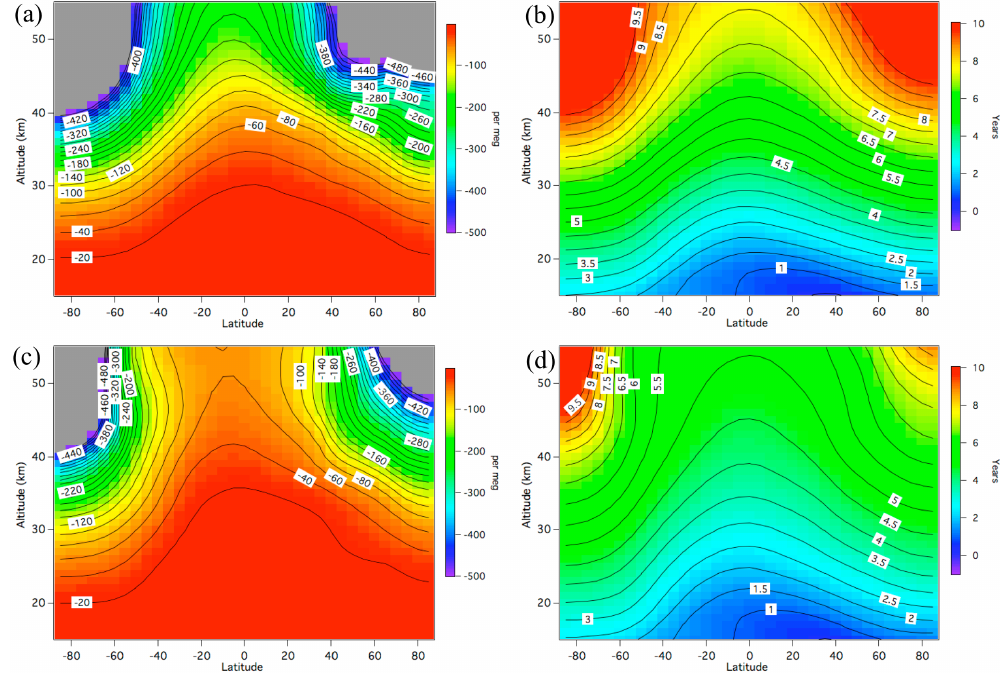
Fig. 4. Annual mean height–latitude distributions of (a) <δ > value (per meg) and (b) CO 2 age (years) calculated using the SOCRATES model for Control Run, and the corresponding results for Enhanced BDC ( c and d ). The δ values lower than − 500 per meg are shown by gray shades. Figure 4. Annual mean height-latitude distributions of (a) < δ > value (per meg) and (b) 5 CO age (years) calculated using the SOCRATES model for Control Run, and the 6 2 corresponding results for Enhanced BDC ((c) and (d)). The < δ > values lower than -500 7 per meg are shown by gray shades. 8